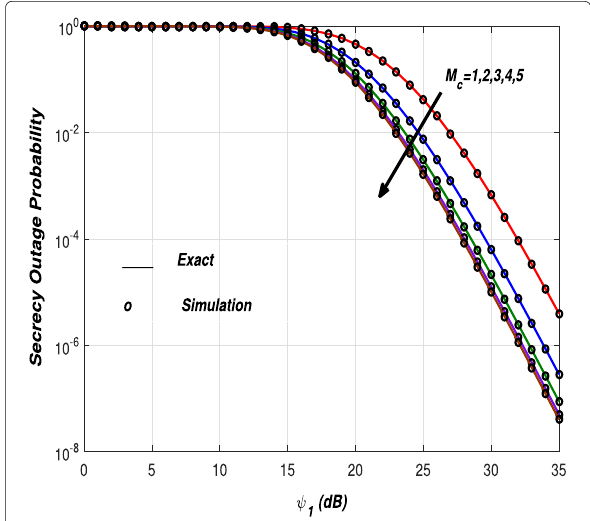
Fig. 2 Secrecy outage probability versus ψ 1 . Secrecy outage probability versus SNR of the main channel ψ 1 for different numbers of selected antennas M c with R s = 1, (cid:3) 2 =10 dB, (cid:3) t =10 dB, σ = 1, and M =